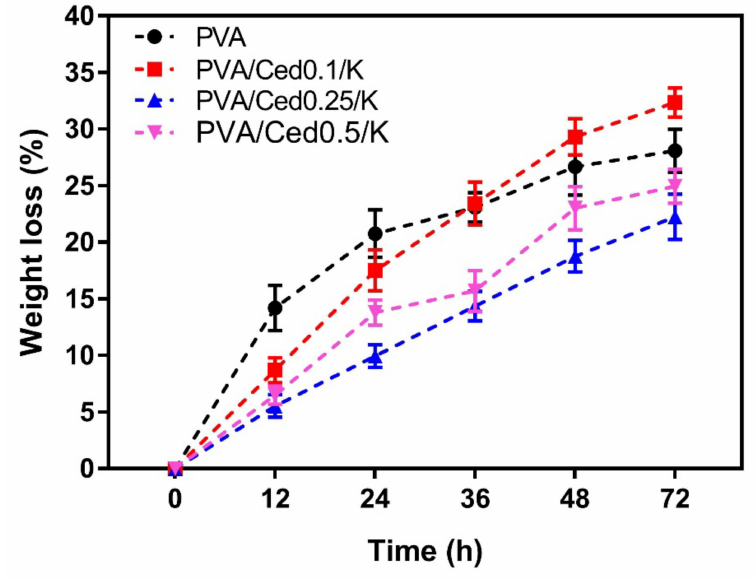
Figure 7. In vitro hydrodegradation of PVA/Ced/K composite sponges. Results are depicted as mean ± SD.